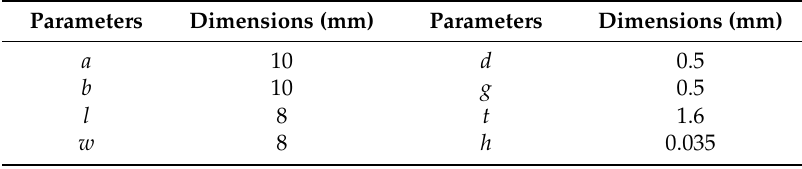
Table 1. Design specification of the Z-shape unit cell.